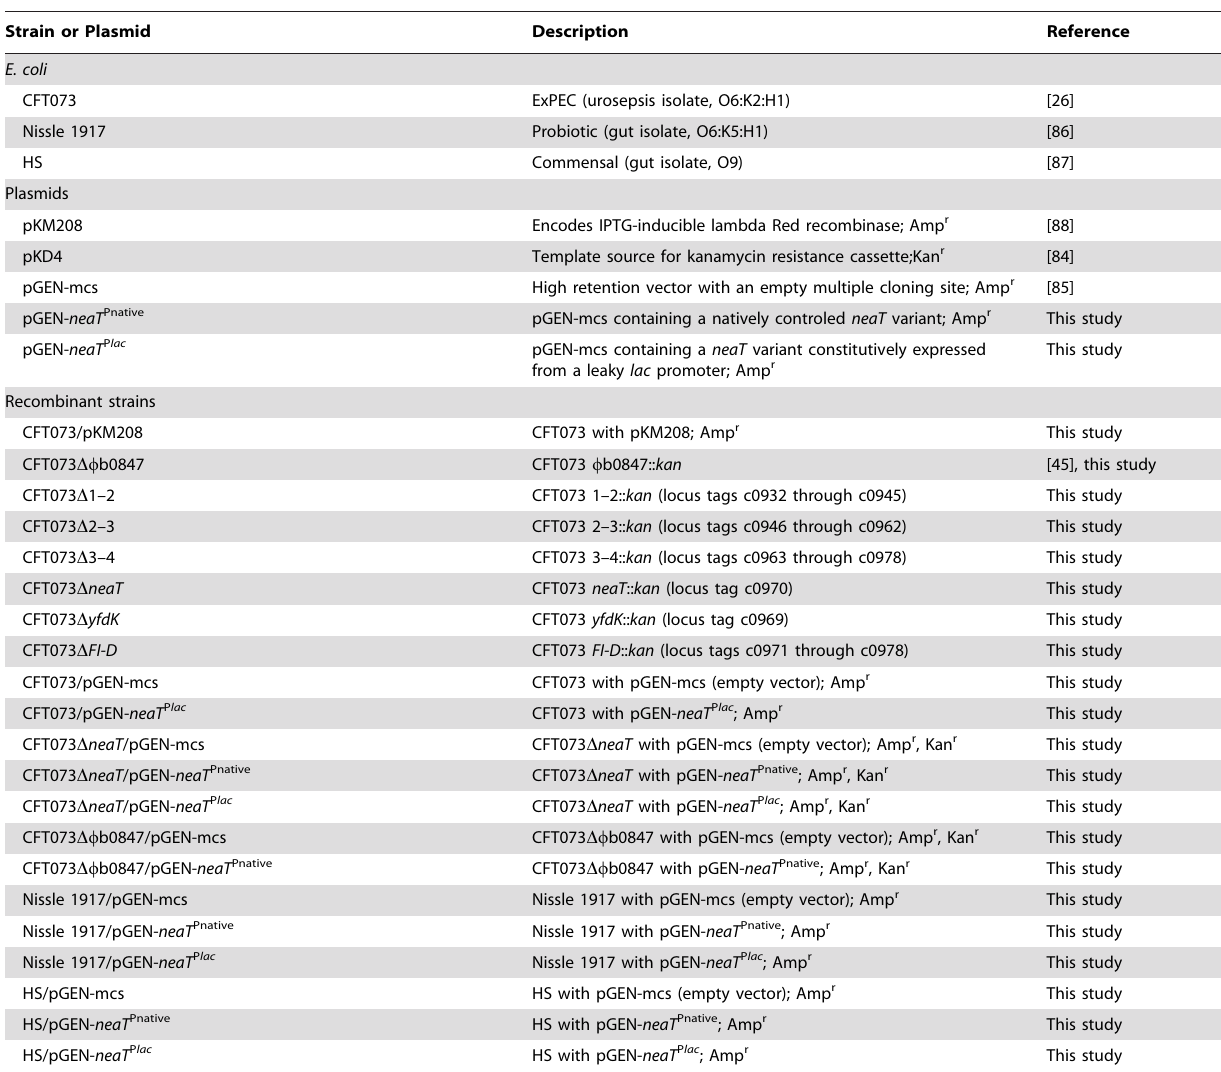
Table 3. Bacterial strains and